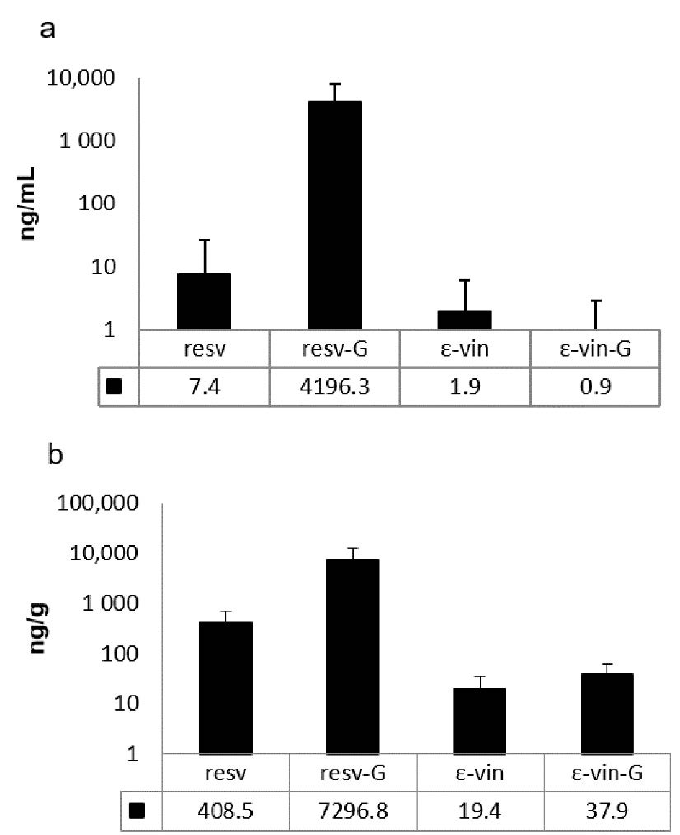
Figure 2. ( a ) Plasma and ( b ) liver concentrations of resveratrol (resv), total resveratrol-glucuronides (resv-G), ε -viniferin ( ε -vin), and total ε -viniferin-glucuronide ( ε -vin-G) 3 h after final dose of 360 mg ST-99/kg b.w Data are expressed as mean ± SD in ng/mL and ng/g for plasma and liver, respectively ( n = 10).